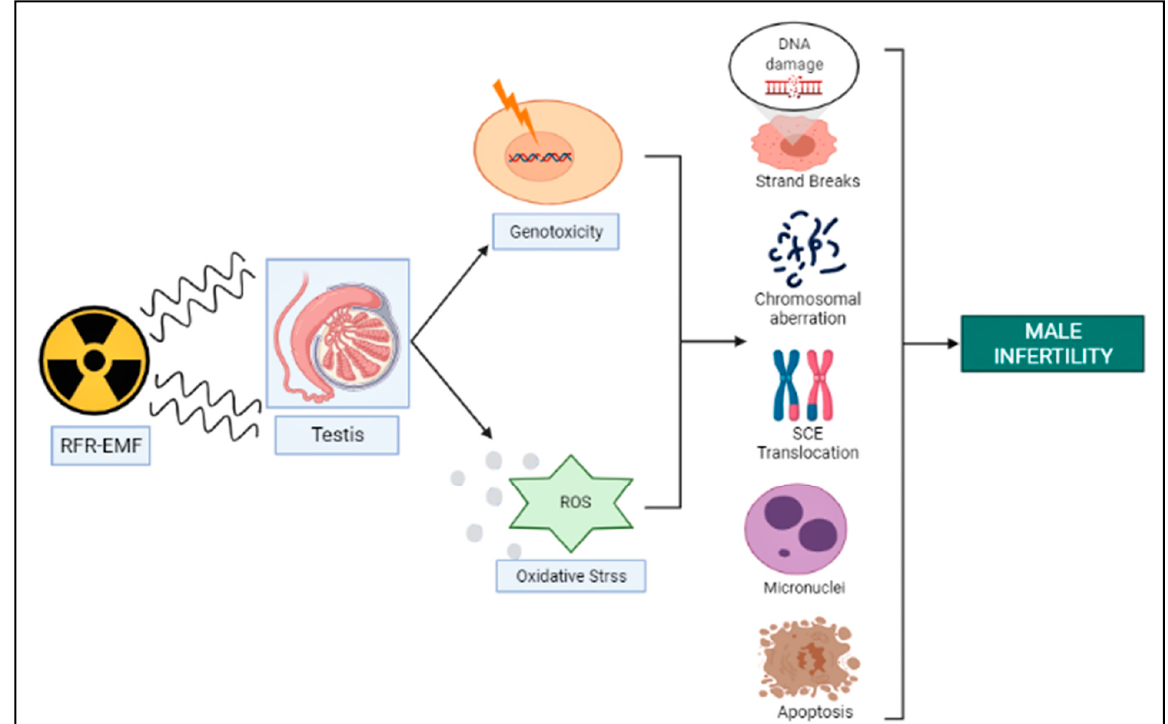
Figure 1. Possible effects of RF–EMF exposure on genotoxic parameters.